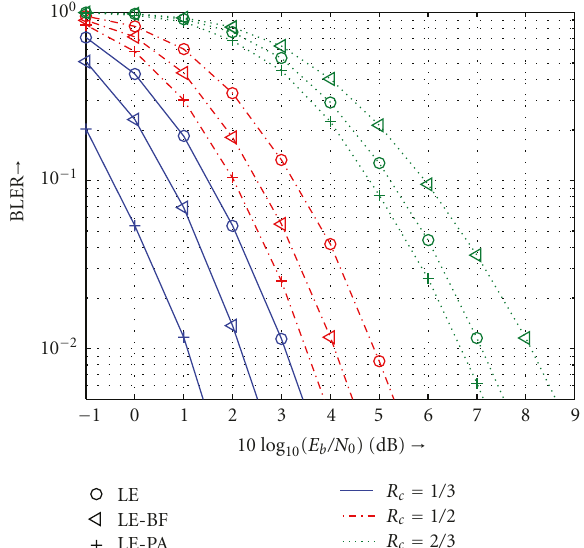
Figure 3: BLER for linear MMSE equalization (LE), LE with beam- forming (LE-BF), and LE with beamforming and power allocation (LE-PA) for Pedestrian B channel.